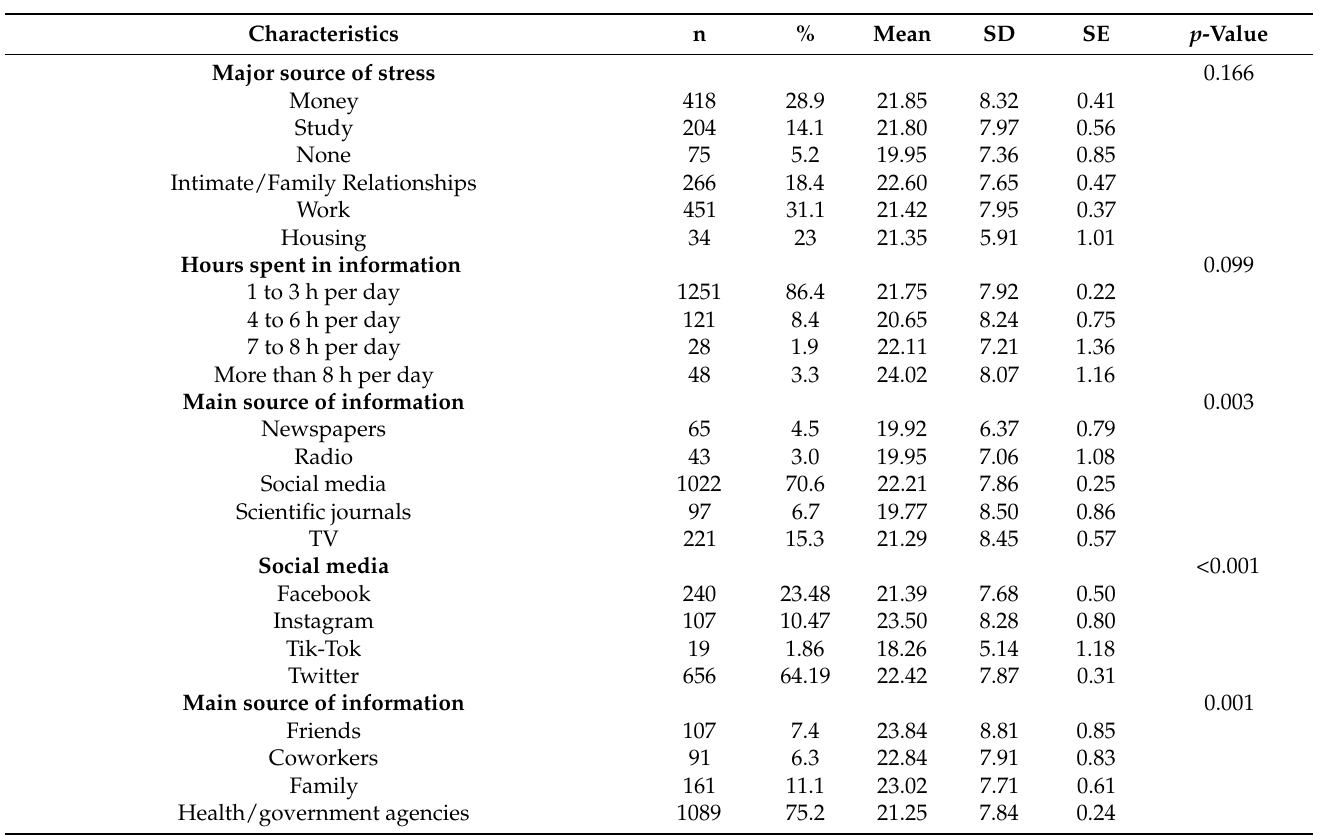
Table 2. Sources of information on the COVID-19 pandemic and associations with levels on the Pandemic Fatigue Scale (PFS scores) (N = 1448).